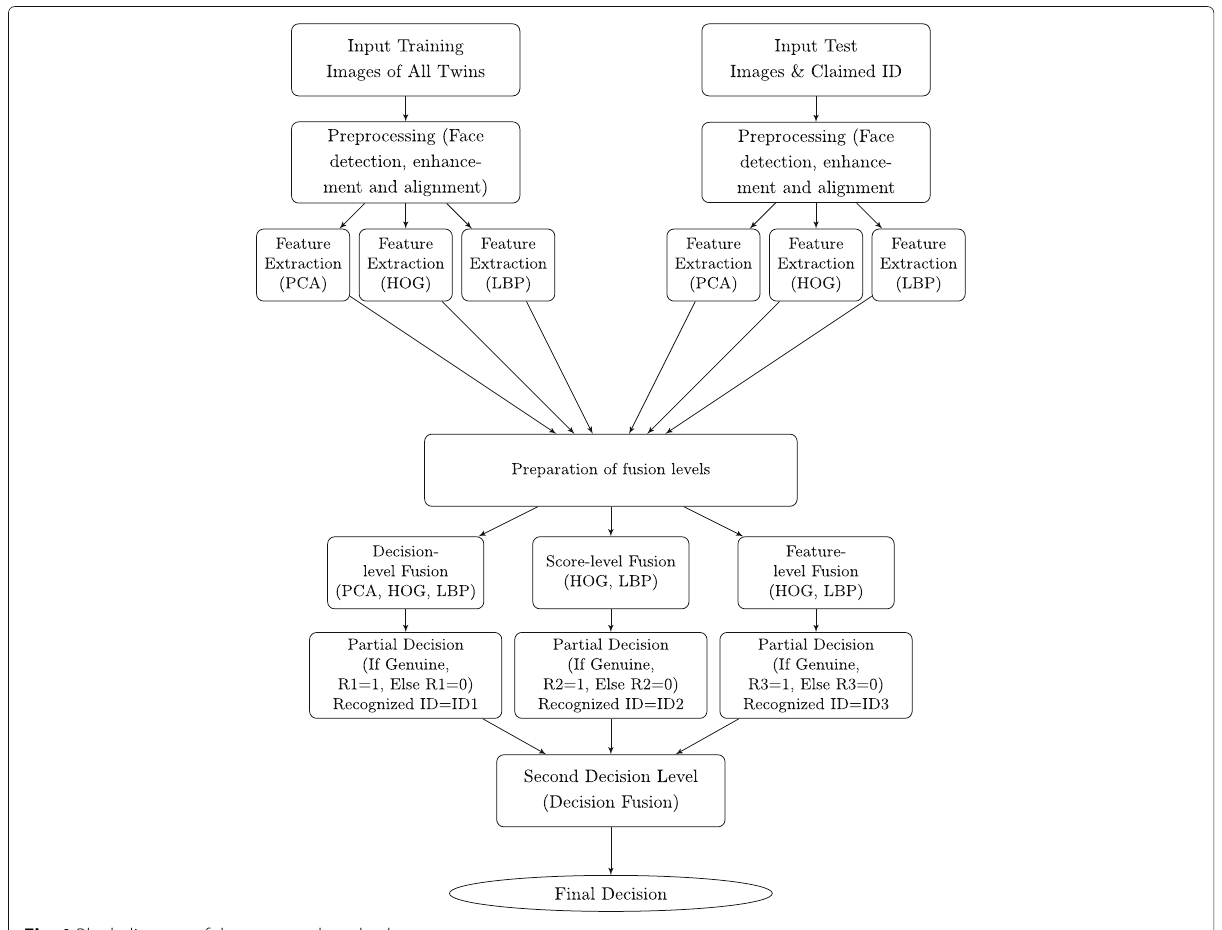
Fig. 1 Block diagram of the proposed method